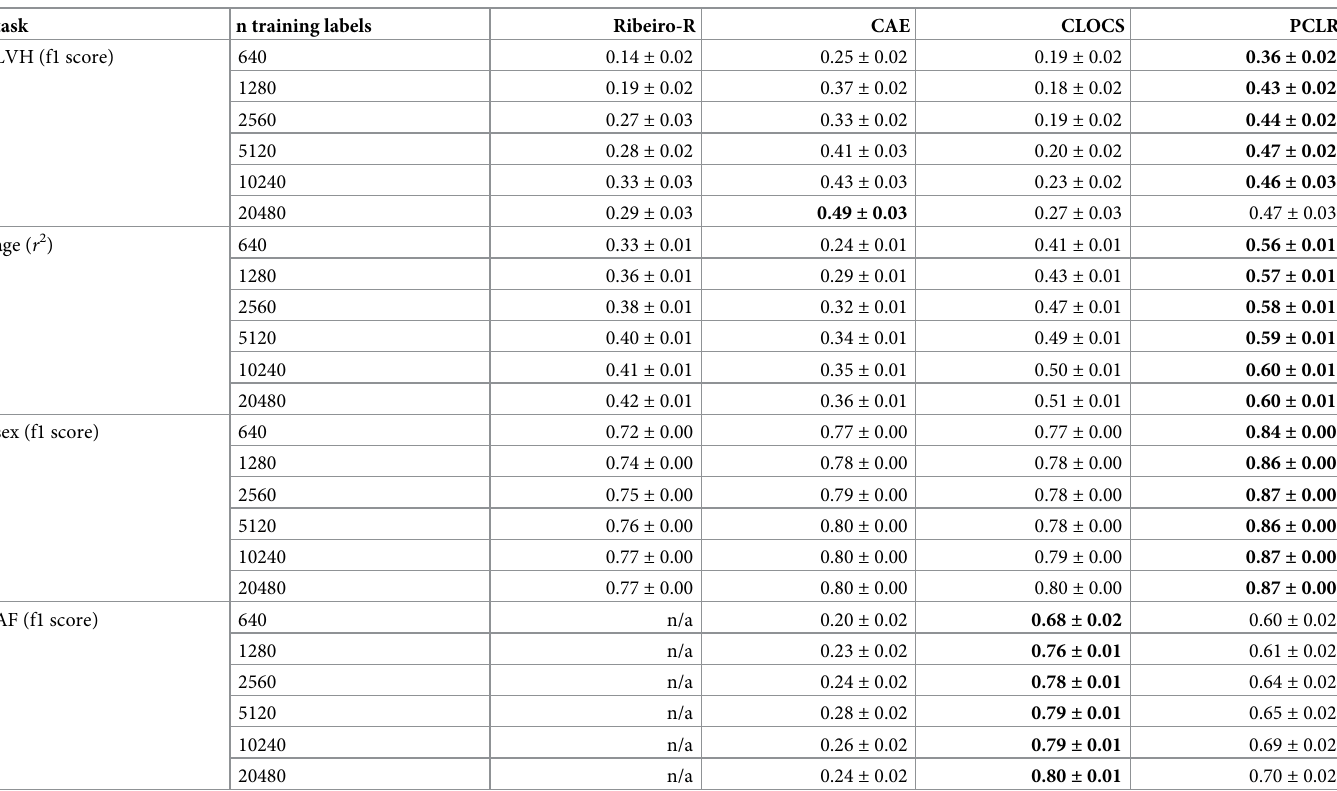
Bold results indicate the best model with a fixed task and number of training labels. The best models are picked using 1,000 bootstraps of the test data. The performance ranges are ± one standard deviation of the bootstrapped performances.